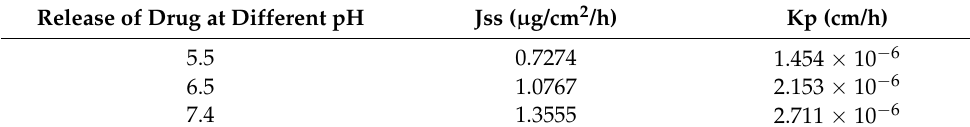
Table 4. Permeability flux (Jss) and permeability coefficient (Kp) at different pH.